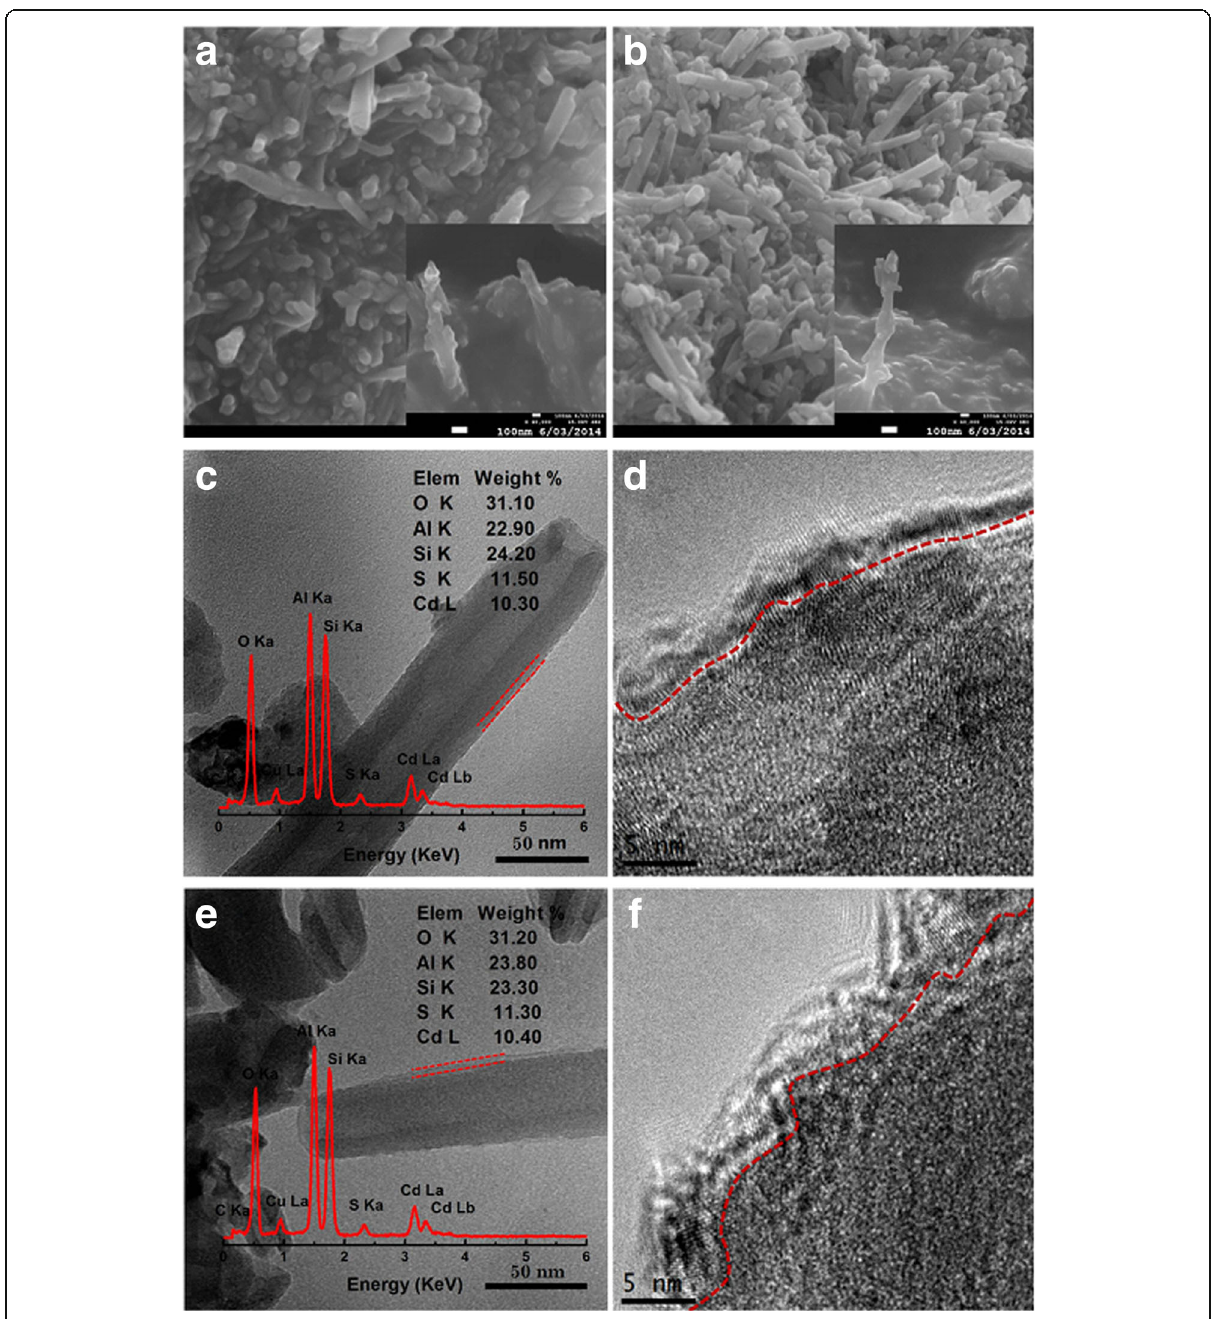
Fig. 3 SEM and TEM images of a , c , d CdS/HNT and b , e , f CdS/La-HNT